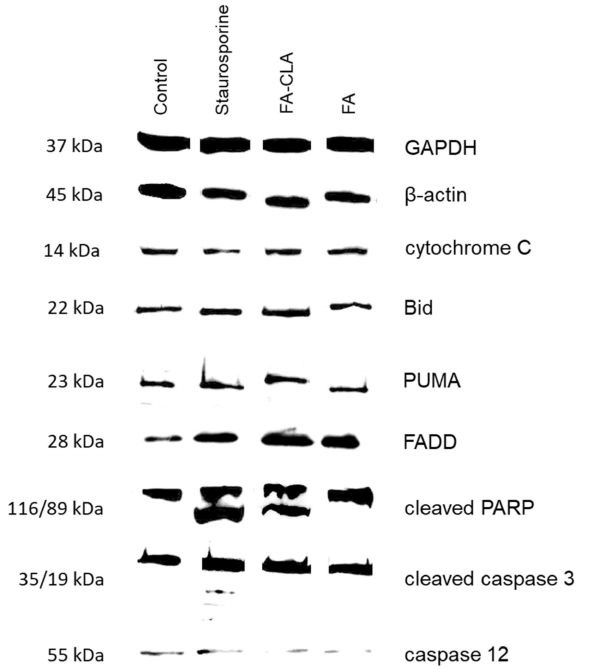
Figure 4. Expression of apoptotic proteins in cancer cells of the WM793 line when exposed to a mixture of fatty acids extracted from yolk enriched and not enriched in